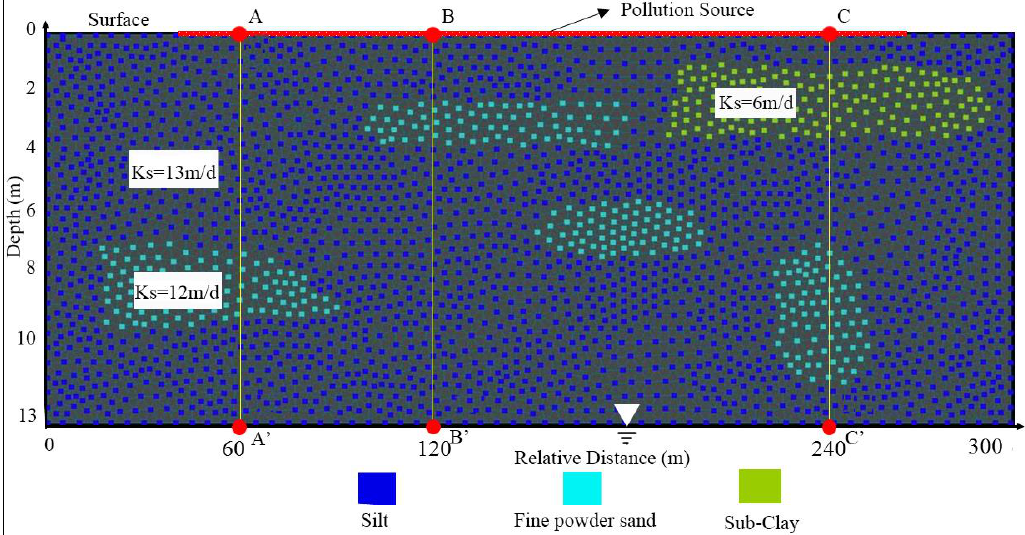
Figure 2. Profile of lithology, grids, and monitoring lines.